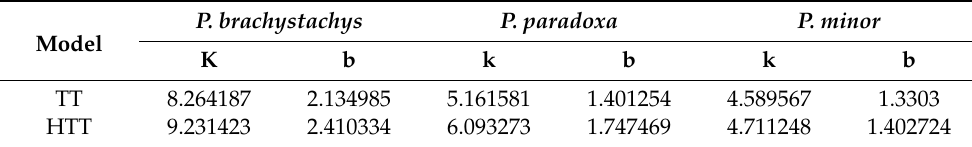
Table 6. Parameters of Weibull Equation (1) for the thermal and hydrothermal time-based models of the three Phalaris species. Model